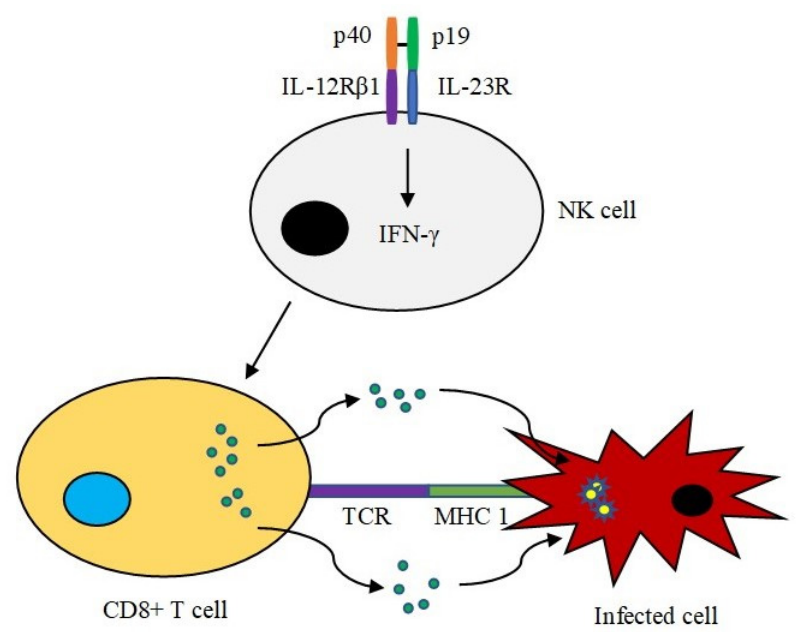
Figure 2. IL-23 activity in NK cells. IL-23 (p40/p19) binds to its receptor on the surface of NK cells. The binding leads to the production of effector IFN- γ . IFN- γ is responsible for promoting CD8+ T-cell responses such as eliminating infected cells in a perforin-dependent manner. The targeted cell undergoes programmed cell death, preventing spread of the virus.